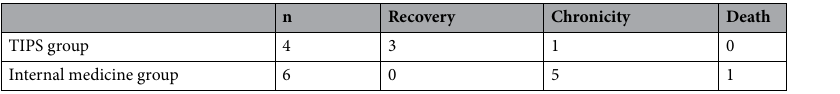
Table 2. Outcome of patients with PA-HSOS. PA-HSOS , pyrrolizidine alkaloid-induced hepatic sinusoidal obstruction syndrome, TIPS , transjugular intrahepatic portosystemic shunt.